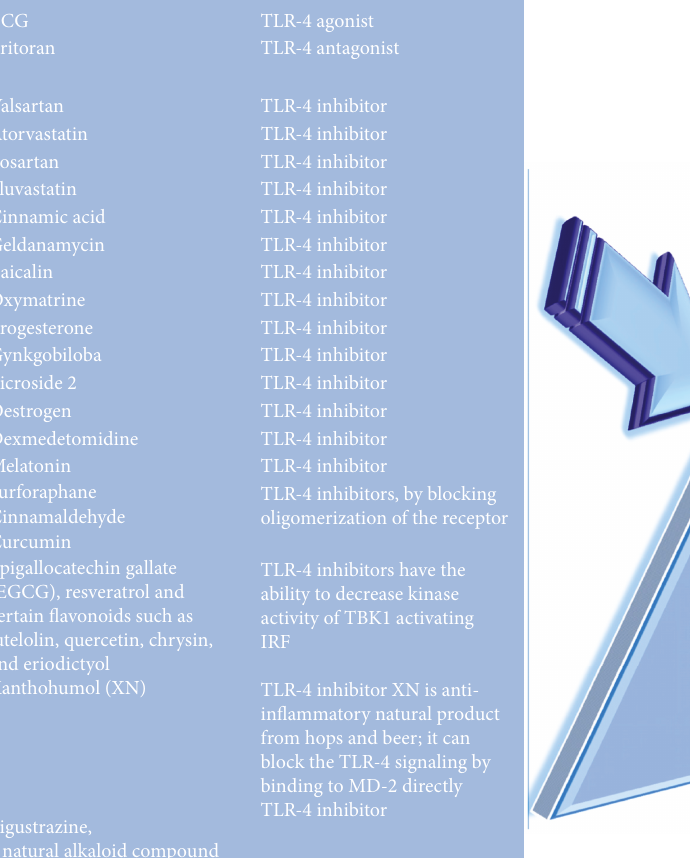
Figure 2: The TLR-4 pathway and a panel of agonist, antagonist, and inhibitor